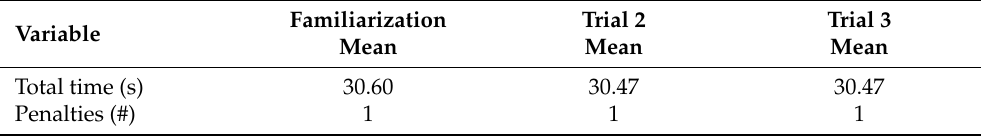
Table 2. Total time and penalties mean values for the three trials.